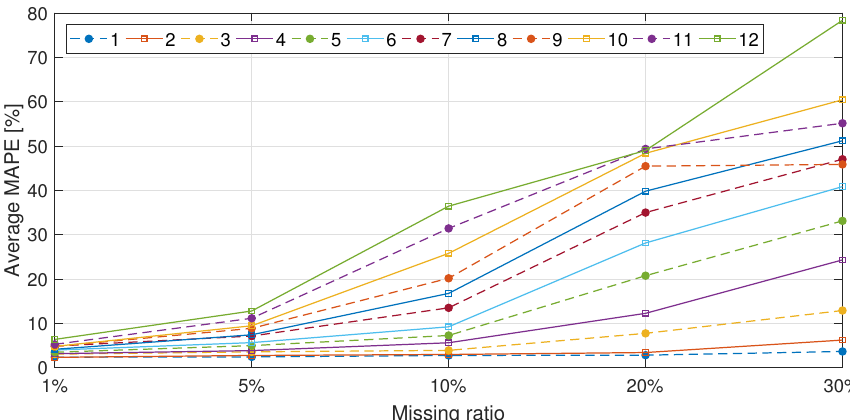
Figure 12. The average MAPE (%) of the proposed eLAI with various missing ratios. Table 5. The average MAPE (%) of the proposed eLAI with various missing ratios (numbers in parentheses are upper bounds of a 95% confidence